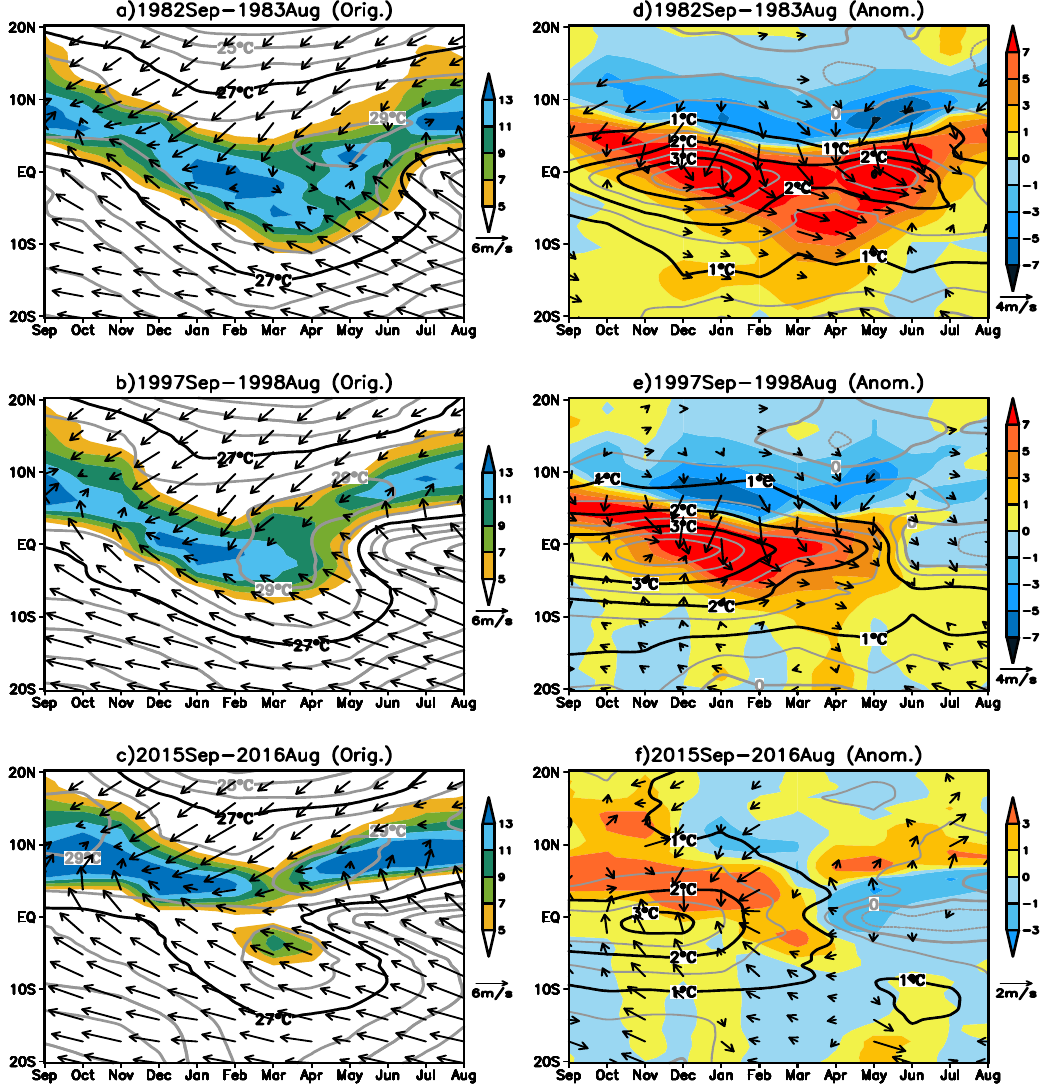
Figure 3. Left panels: Seasonal evolution of original zonal-mean precipitation (color shaded; mm/day), SST (contours; ◦ C), and surface winds (vectors; m/s; wind speed smaller than 1 m/s has been masked out) over the eastern Pacific (140 ◦ W–80 ◦ W) for three extreme events: ( a ) 1982/1983, ( b ) 1997/1998, and ( c ) 2015/2016. Right panels: ( d ) 1982/1983, ( e ) 1997/1998, and ( f ) 2015/2016, i.e., seasonal evolution of zonal-mean precipitation, SST, and surface winds, but for their anomalies.